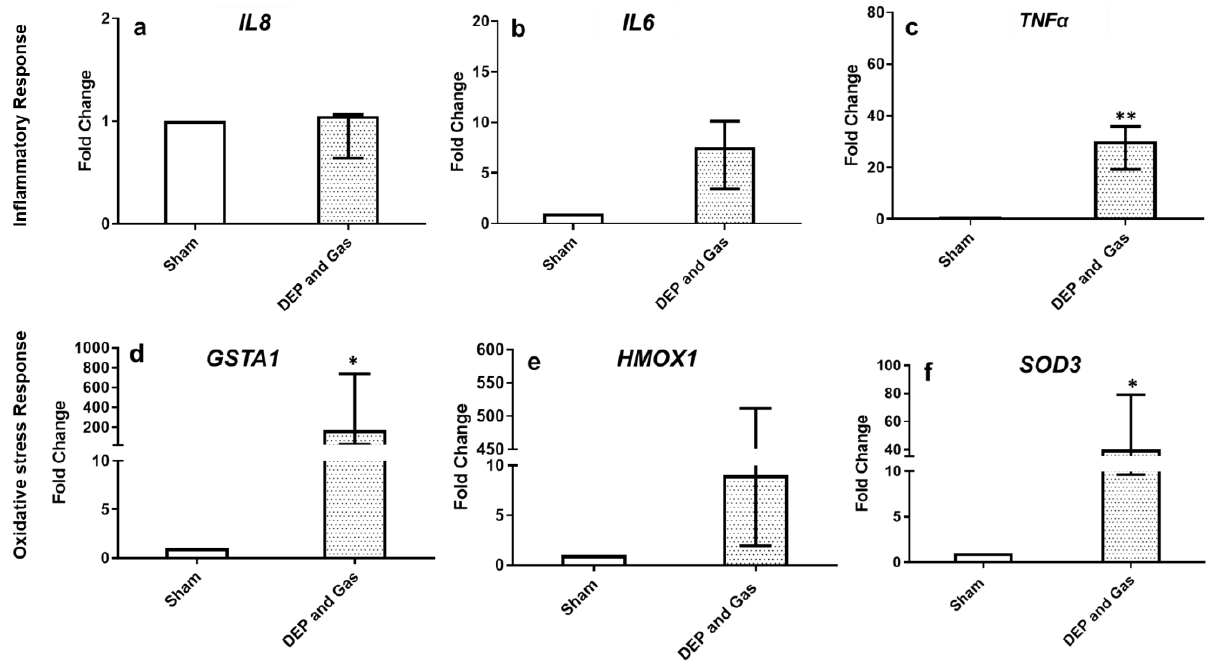
Figure 7. mRNA expression of inflammatory and oxidative stress markers following single combined exposure to diesel exhaust particles (DEP:12.7 µg/cm 2 ) and gaseous air pollutants (0.1 ppm NO 2 , 0.2 ppm SO 2 ). Fold change in inflammatory ( IL8, IL6, and TNFα ( a – c )) and oxidative stress [GSTA1, HMOX1, and SOD3 ( d – f )] in bronchial mucosa models developed at air – liquid interface (bro-ALI) following incubation for 24 h after exposure to sham (control: clean air exposure) and combined air pollutants. Data presented as median and 25th – 75th percentiles, fold change = 2- ΔCt of models/2- ΔCt of sham -exposed bro-ALI. N = 3 donors and n = 2 replicates/Donor. p < 0.01 **: significant compared to sham. p < 0.05 *: significant compared to sham